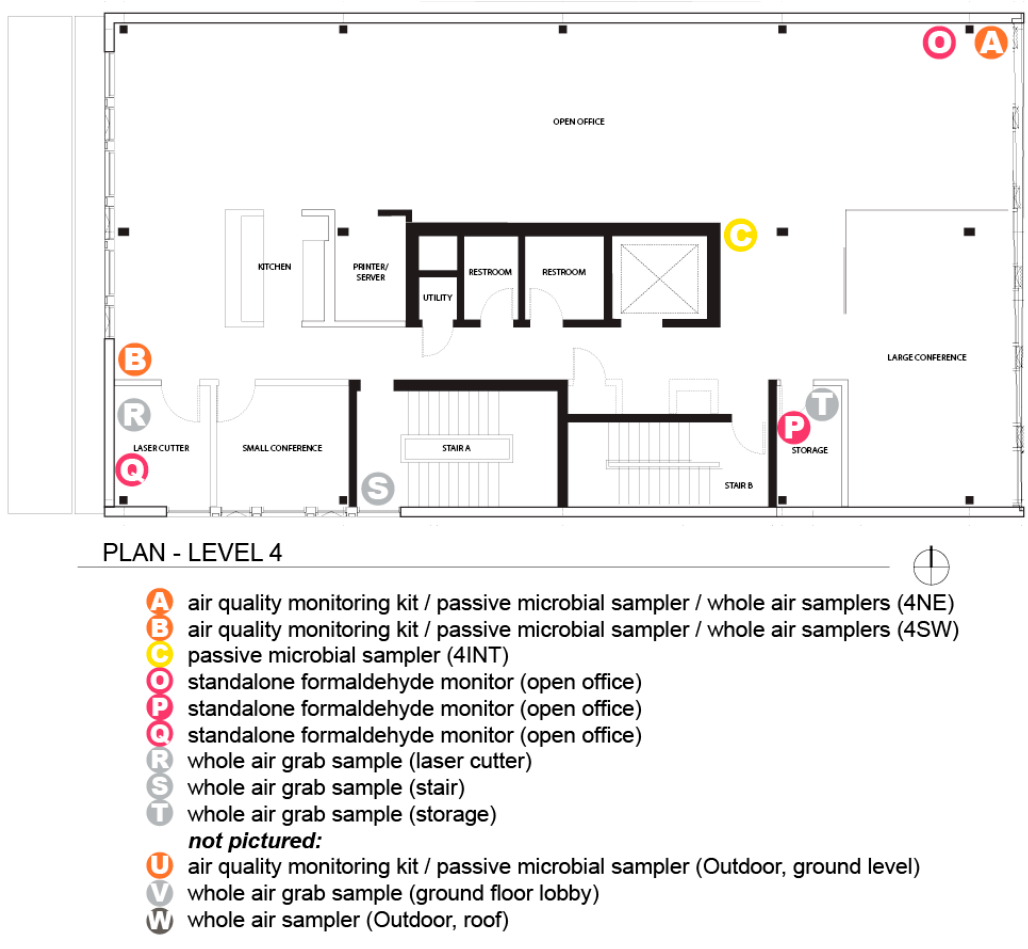
Figure 1. Annotated Level 4 Plan of Albina Yard showing air quality and microbial, monitoring and sampling locations.